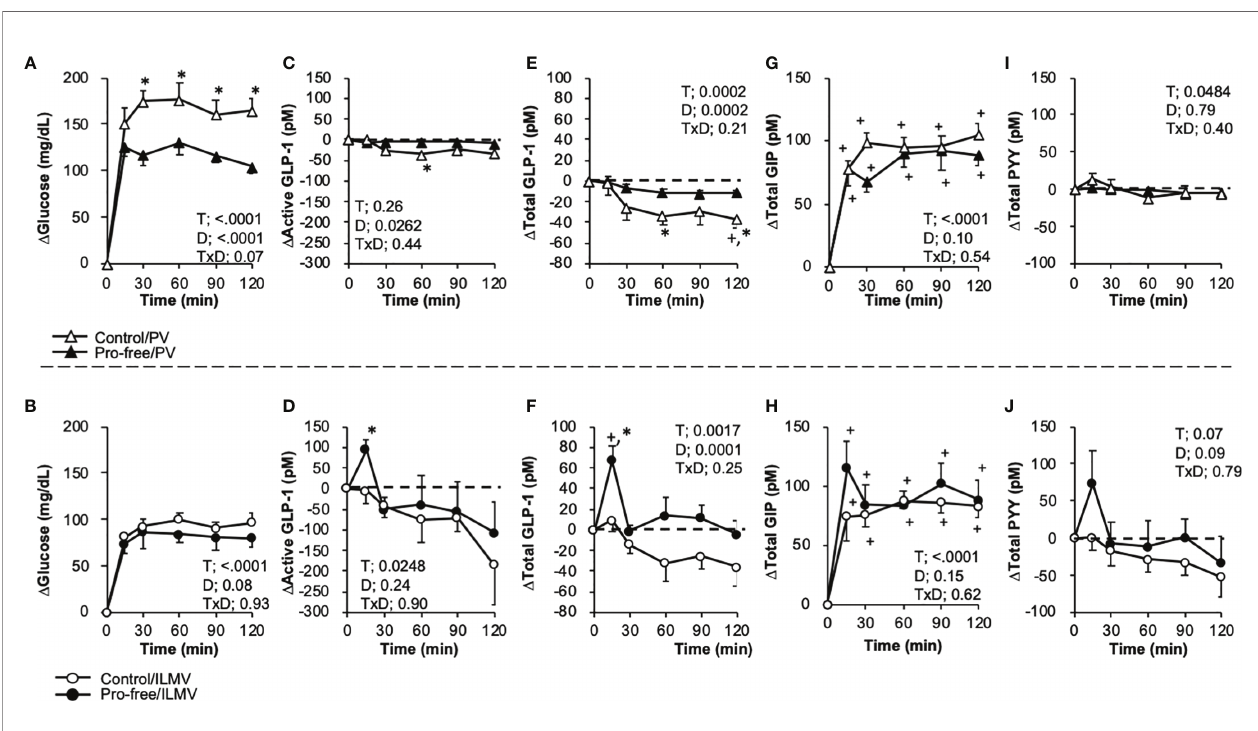
FIGURE 3 | Changes in glucose, active and total GLP-1, and PYY concentrations in the portal vein (PV) plasma and the ileal mesenteric vein (ILMV) plasma after the ingestion of the diet-containing protein (control) or the diet-not containing protein (pro-free), respectively. Rats were provided the control diet (containing casein at 25% wt/wt) or the pro-free diet at the dose of 10 g/kg body weight, after 24-h fasting. Blood samples were collected from the catheters before (0 min) and after providing the meal. Results are presented as the change ( D ) from the basal values of individual parameters in each group. Data (A, B) glucose, (C, D) active GLP-1, (E, F) Total GLP-1, (G, H) Total GIP, (I, J) Total PYY) are presented as mean values and SEM (n = 10 in Control/PV, n = 8 in Pro-free/PV, n = 5 in Control/ILMV, n = 6 in Pro-free/ILMV for glucose, active GLP-1 and total PYY; n = 10 in Control/PV, n = 8 in Pro-free/PV, n = 4 in Control/ILMV, n = 5 in Pro-free/ILMV for total GLP-1). P values calculated by two-way repeated-measures ANOVA for effects of time (T), diet (D), and their interactions (TxD) are presented in each of the panels. Asterisks (*) indicate signi fi cant difference between the value at the same time point (P < 0.05, Student ’ s t-test). Plus (+) signs indicate signi fi cant difference compared to the basal value of each group (P < 0.05, Dunnett ’ s test). Dashed lines represent the basal level (Y = 0) in each of the